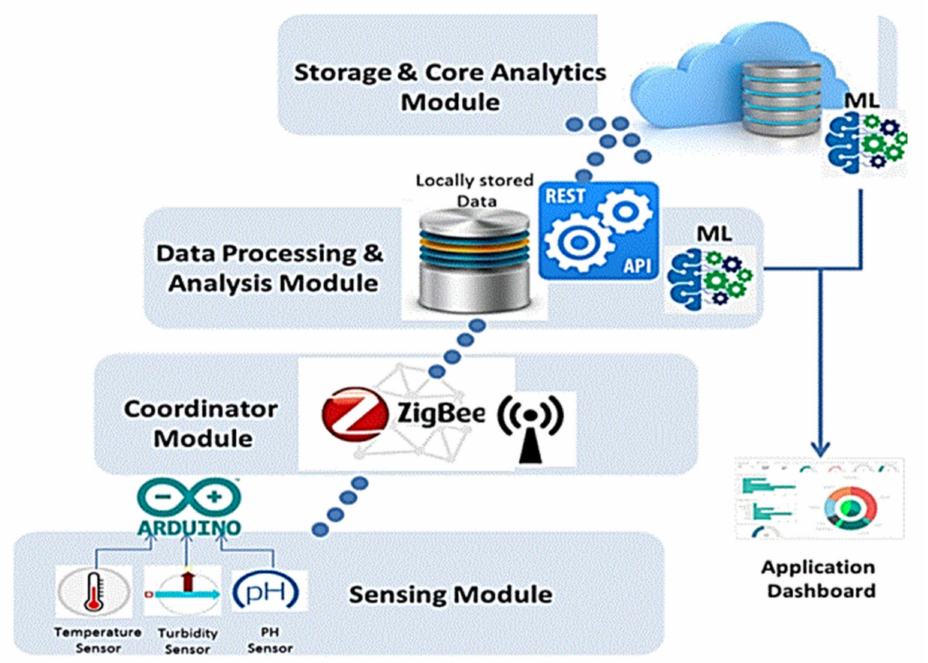
Figure 3. IoT-WQMS proposed in